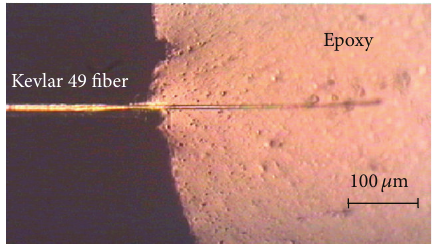
Figure 5: Single fiber pullout specimen